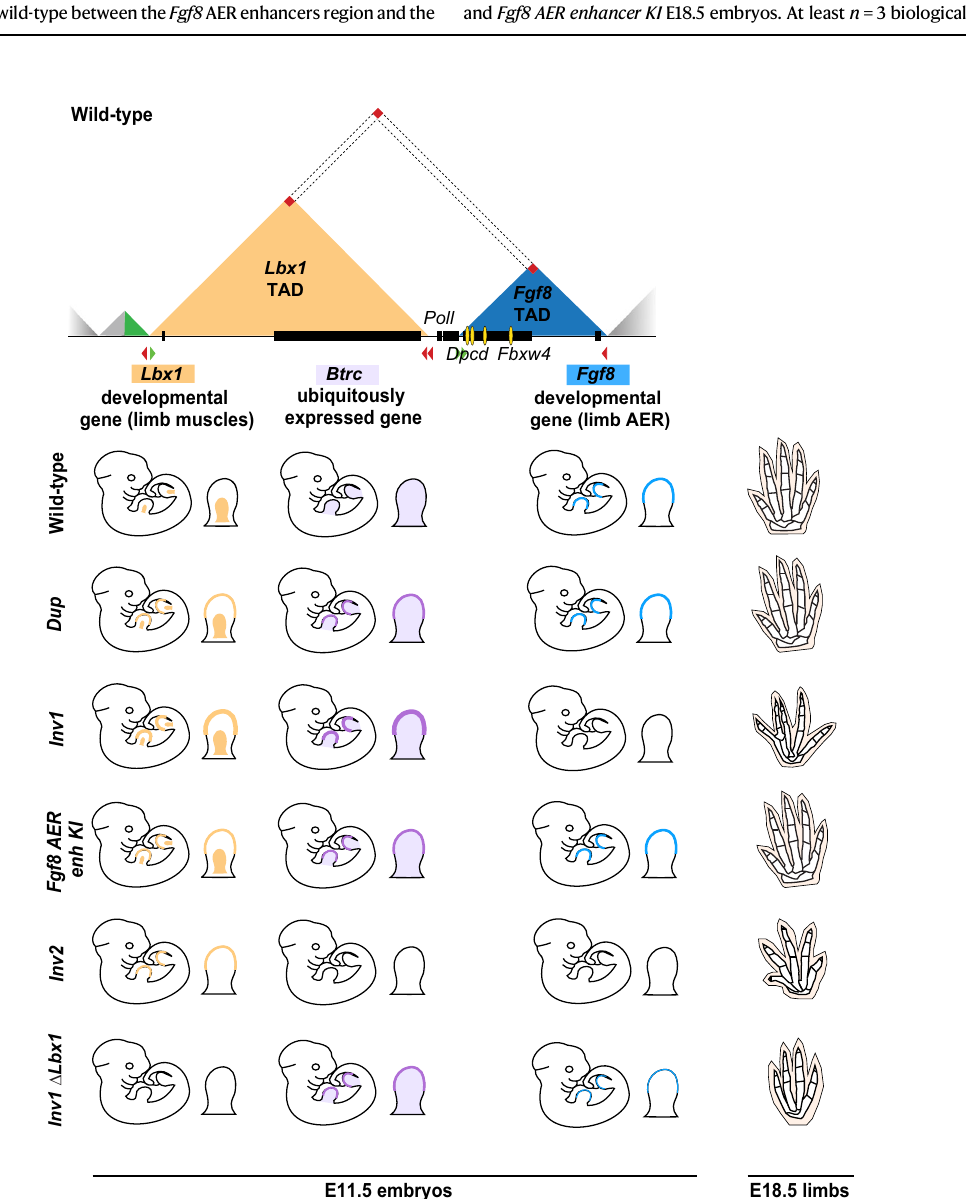
Fig. 6 | Misexpression of both Lbx1 and Btrc is required to develop a SHFM phenotype. a Schematics of the Lbx1 / Fgf8 locus for CRISPR/Cas9 Inv2 and Inv1 Δ Lbx1 alleles.Yellowovalshighlight Fgf8 AERenhancers. b cHi-C(dataareshownas merged signal of n =3 biological and 1 technical replicates) of homozygous Inv2 from E11.5 mouse limb buds. The subtraction map between wild-type and Inv2 interactions is shown in mirror view. Dashed circles indicate the position of the original wild-type interactions between boundaries, two of them lost upon reshuf fl ing of the boundary between Lbx1 and Fgf8 TADs as a consequence of this inversion. The boundary involved in the inversion is shown as blurry. Black arrowhead highlights the bow tie con fi guration representative of the inverted regions. The rectangular dashed area highlighted by black asterisks show ectopic interactionscomparedtowild-typebetweenthe Fgf8 AERenhancersregionandthe